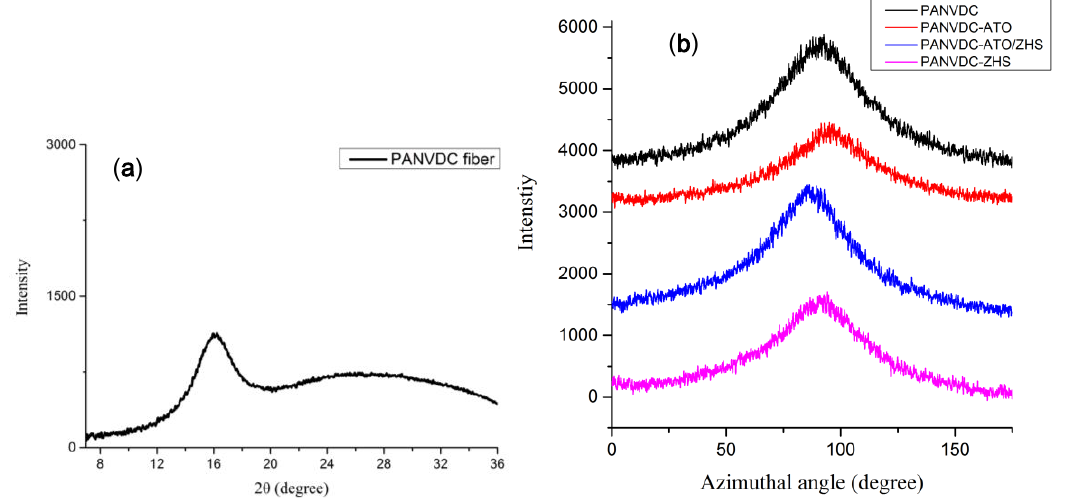
Figure 10. ( a ) The XRD graph of PANVDC fiber. ( b ) The azimuthal graph of PANVDC fiber with flame retardants. Table 7. The degree of crystal orientation in the PANVDC fibers with flame retardants. Sample